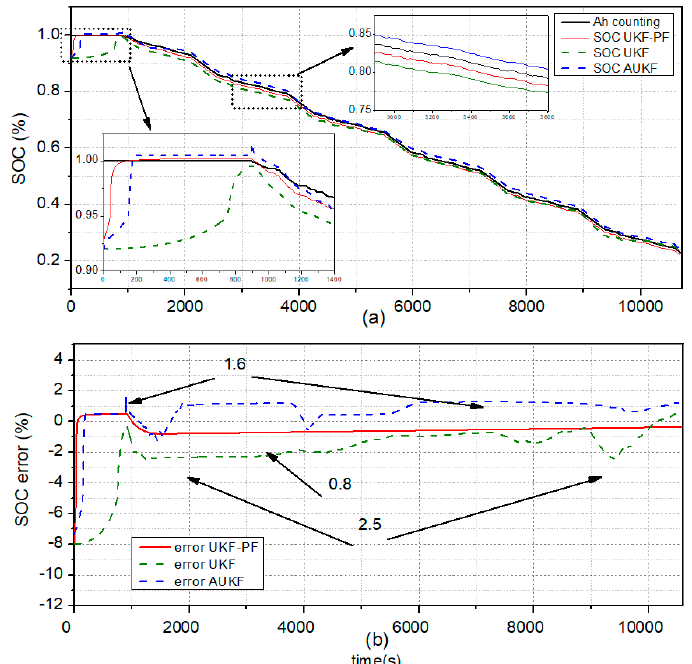
Figure 6. SOC estimation results with unscented Kalman filter (UKF), Adaptive Unscented Kalman Filter(AUKF), and the proposed UKF- particle filter (PF) method: ( a ) SOC estimation results of the different methods; ( b ) SOC estimation error. Table 2. Comparison of performances of the different estimation